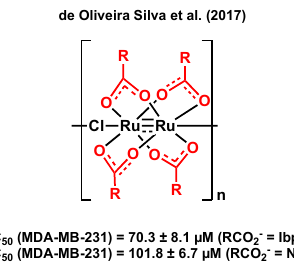
Figure 4. Ruthenium complexes bearing nonsteroidal anti-inflammatory drugs (NSAIDs), encapsulated into solid-polymer-lipid nanoparticles (SPLNs).